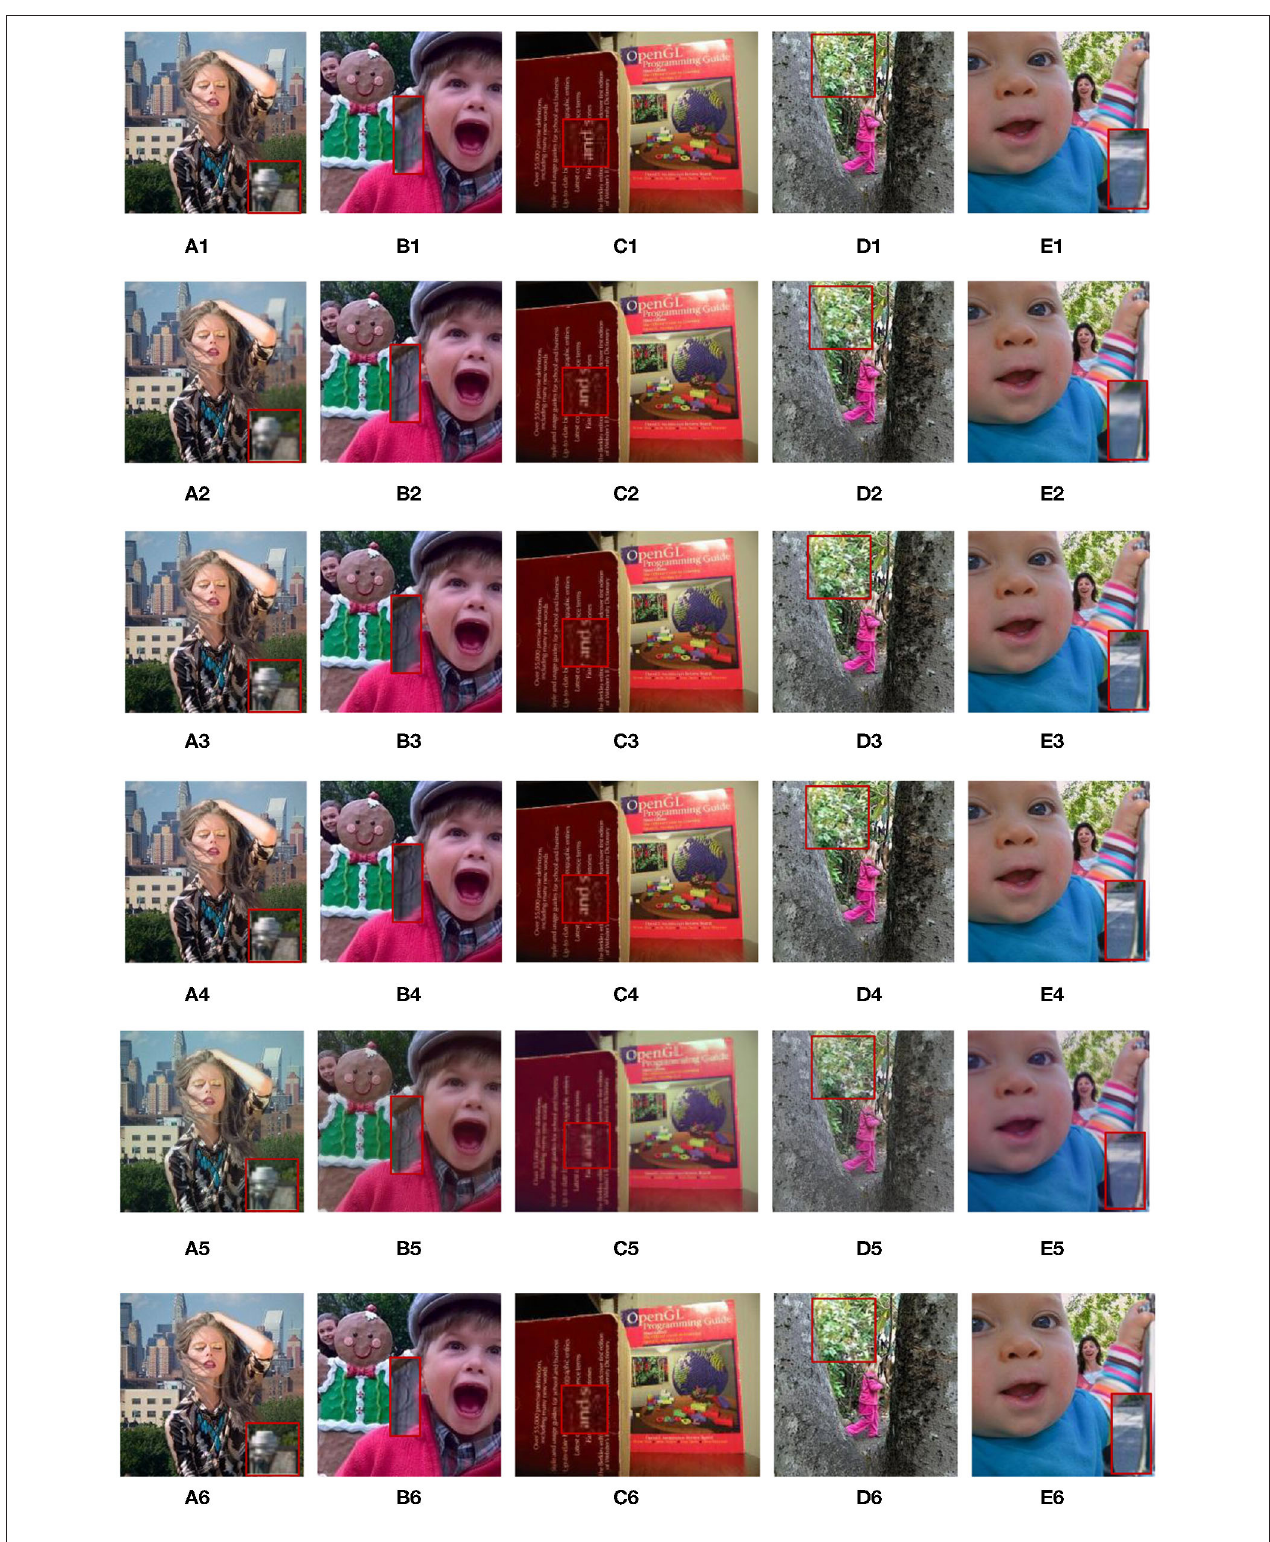
FIGURE 5 | Corresponding to the fusion results of the five original images in Figure 4 . A(1)–E(1) are the fusion images obtained by the GFDF method. A(2)–E(2) are the fusion images obtained by the MWGF method. A(3)–E(3) are the fusion images obtained by the CNN method. A(4)–E(4) are the fusion images obtained by the RWTS method. A(5)–E(5) are the fusion images obtained by the MSVD method. A(6)–E(6) are the fusion images obtained by the QMSVD method.